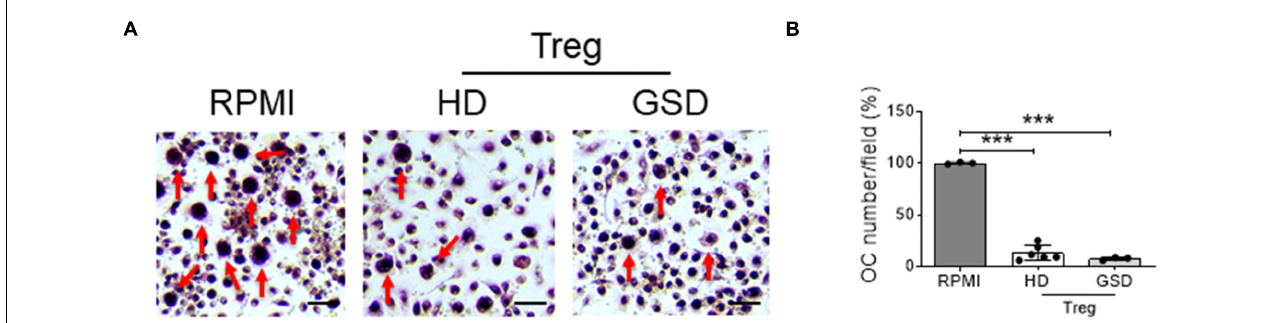
FIGURE 4 | Peripheral Blood Mononuclear Cells (PBMC) were isolated from three HD, treated with hRANKL/hM-CSF and co-cultured with six HD and three GSD aCD3/CD28-stimulated and sorted Treg. As control, cells were treated with hM-CSF/hRANKL and RPMI-1640. (A) Representative picture of TRAcP staining. Scale